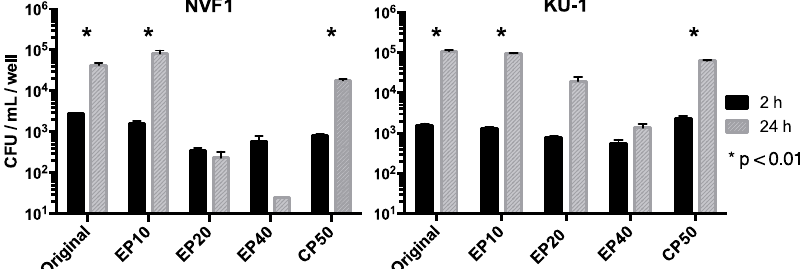
Figure 6. Intracellular growth of passaged variants of NVF1 and KU-1. Original and the variants passaged on Eugon chocolate agar 10, 20, and 40 times (EP10, EP20, and EP40, respectively) and the variants passaged on Chamberlain’s chemically defined medium-based agar 50 times (CP50) of NVF1 and KU-1 strains were inoculated into J774.1 cells. Viable bacteria per well were determined at 2 and 24 h post inoculation. Results are shown as colony-forming unit (CFU) / well. The bars represent the means + SEM of bacterial CFUs from triplicate samples. *, p -values less than 0.01 by multiple t -test were considered statistically significant. EP20 and EP40 of both NVF1 and KU-1 strains did not significantly increase between 2 and 24 hpi